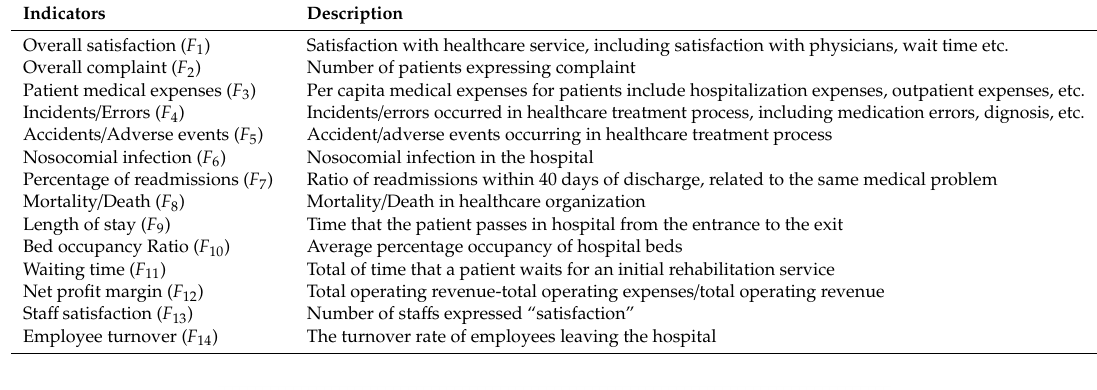
Table 1. Performance indicators considered in this case study.